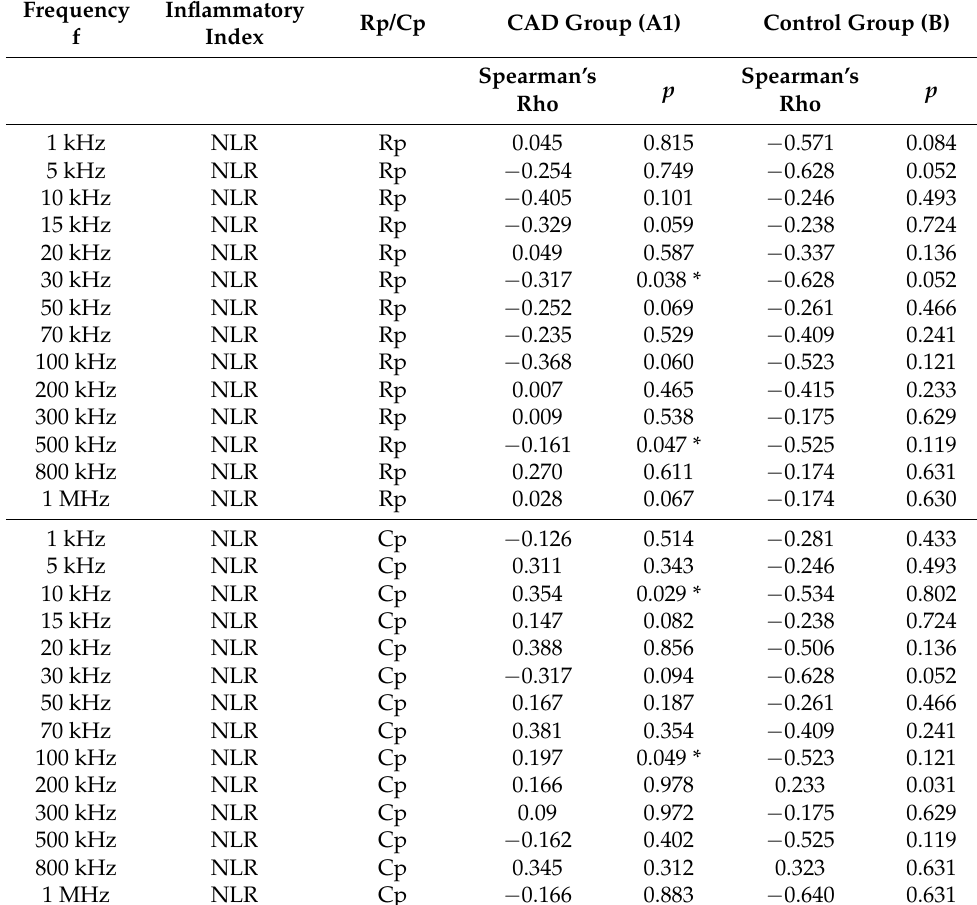
Table 4. Correlation between EIS measurements and inflammatory